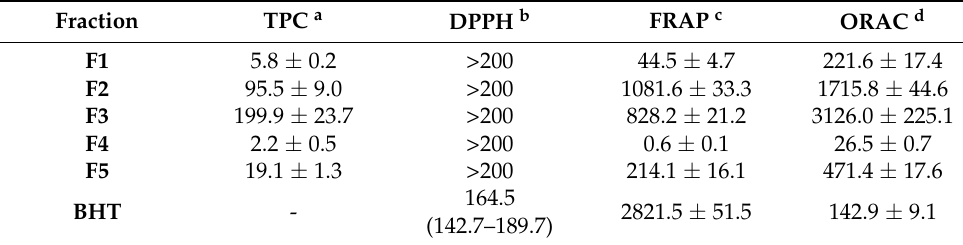
Table 1. Antioxidant capacity of Saccorhiza polyschides .